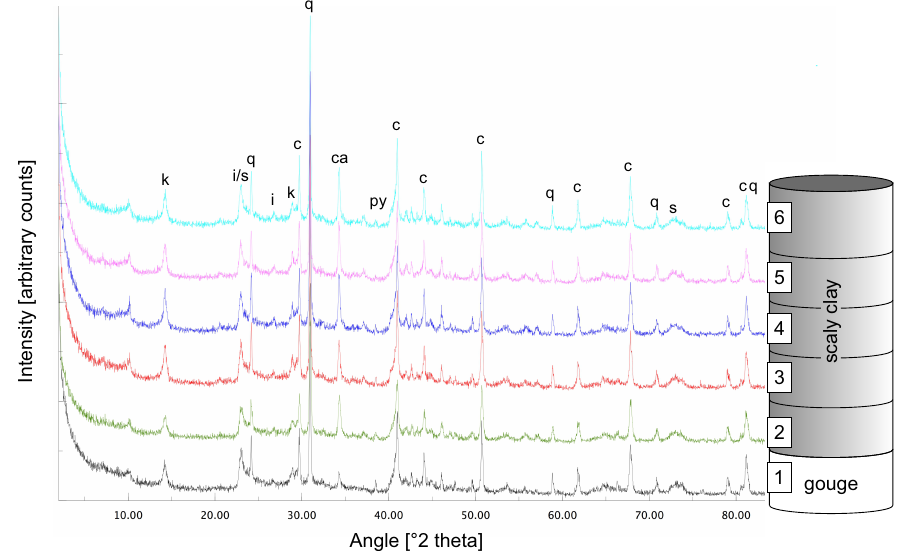
Figure 15. Stack of six X-ray diffraction patterns from sample BPS12-4. Pattern 1 belongs to a gouge layer, pattern 2 is 1cm from gouge, pattern 3 is 2cm from gouge and so forth (sketched). Note that there is no obvious change in the pattern except a reduced calcite peak in gouge. Measurements were performed on a Huber MC9300 diffractometer using CoKa radiation produced at 40kV and 40mA. k: kaolinite;